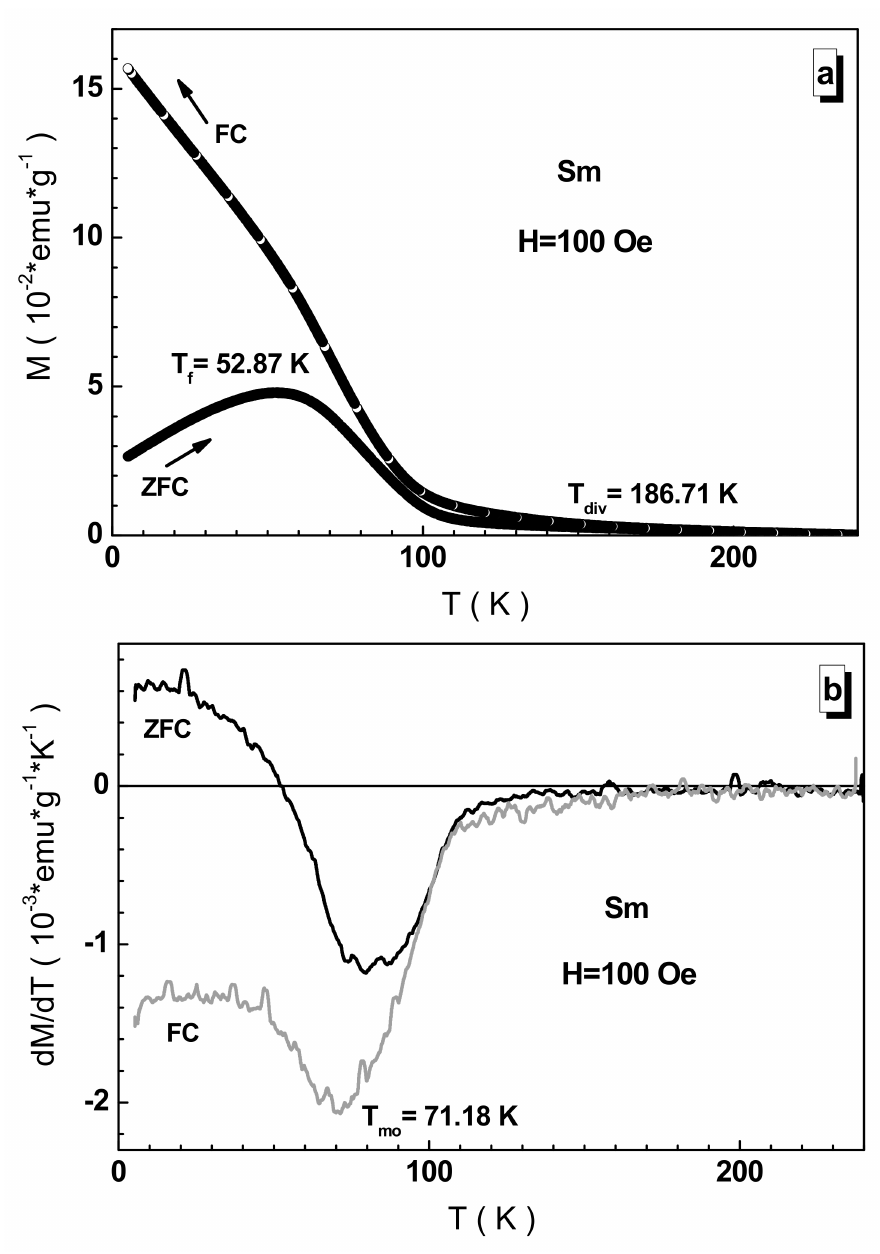
Figure 8. ZFC (full circle) and FC (open circle) curves of M(T) temperature magnetization ( a ) and their dM/dT(T) first magnetization derivative ( b ) for the Sm-based sample in 100 Oe. Inset demonstrates the temperature magnetization on a larger